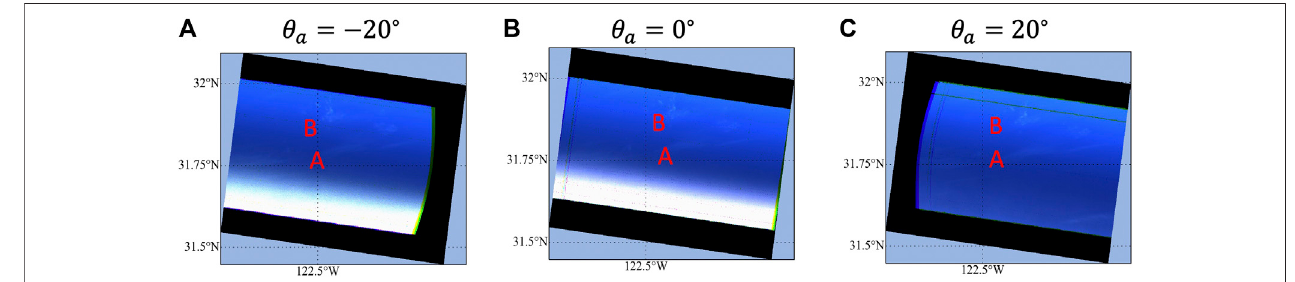
FIGURE 6 | (A-C) RGB images of the AirHARP measurements at 10/23/2017 at three different along track viewing angles ( θ a (cid:2) − 20 ° , 0 ° , 20 ° ).Two cloud patches are indicated by A and B.